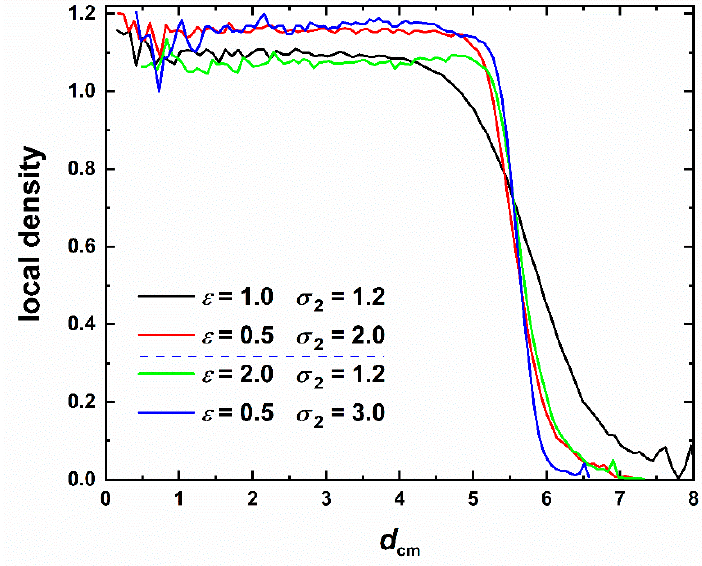
Figure 13. Local density as a function of the distance from the center of the cluster, d cm , for SW chain systems corresponding to different pairs of intensity, ε , and range, σ 2 , of interactions. Dashed horizontal blue line in legend identifies transition between the crystal and glass phase regimes.